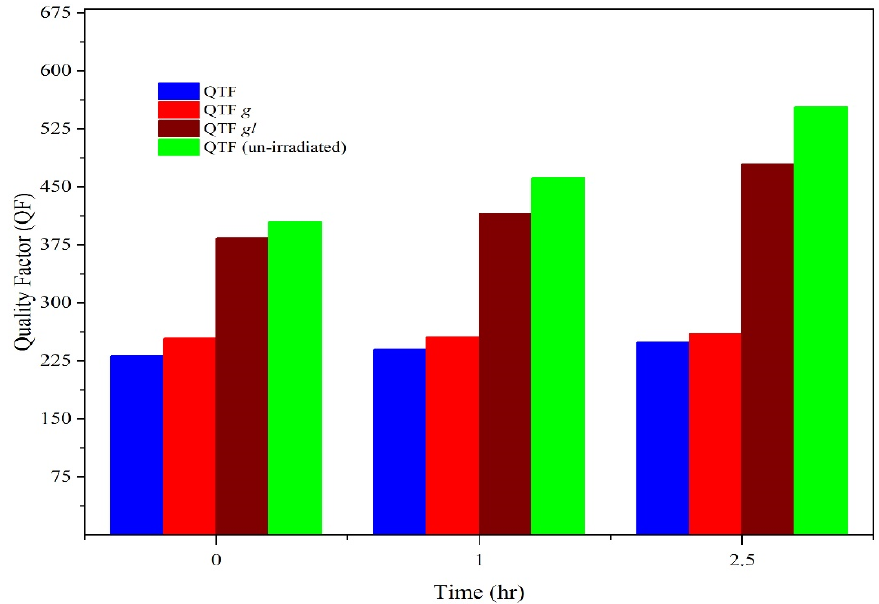
Figure 3. Change in the quality factor of QTFs with exposure time.